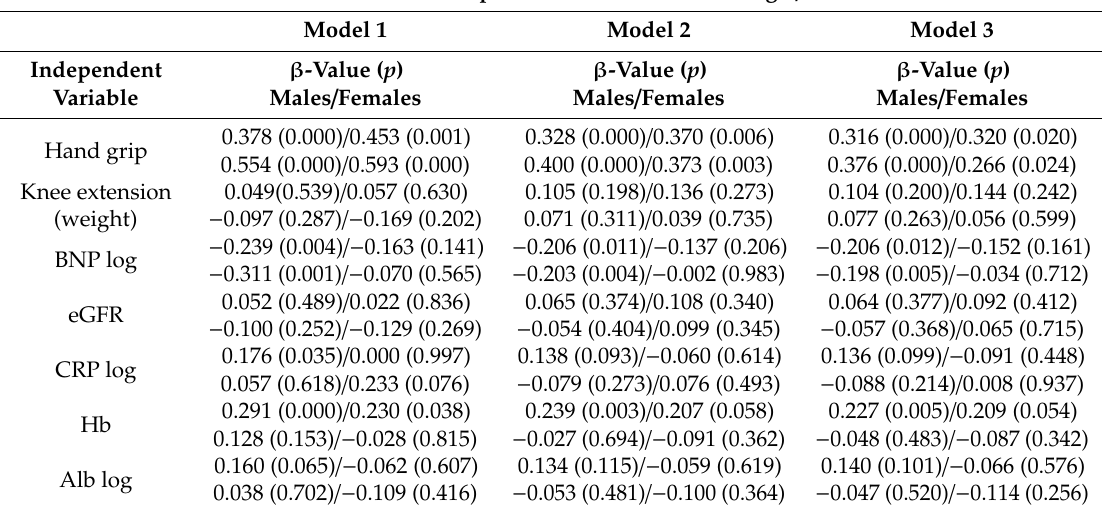
Table 3. Multivariate linear regression analysis of the phase angle / SMI and various parameters (males /